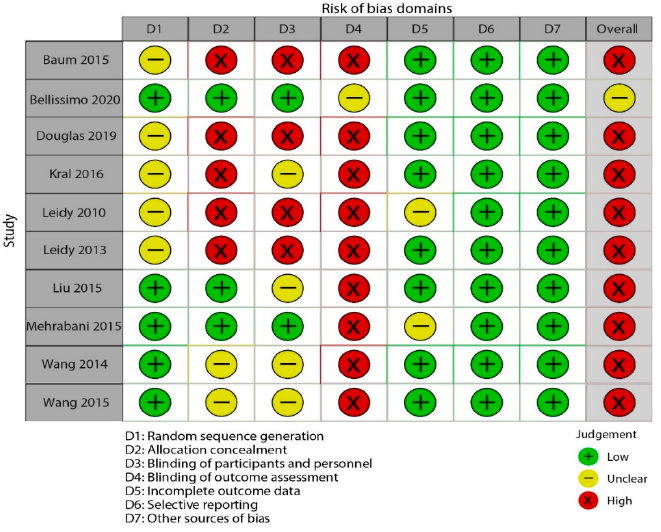
Figure 2. Study quality and risk of bias assessment of included studies in the meta − analysis (traffic light).